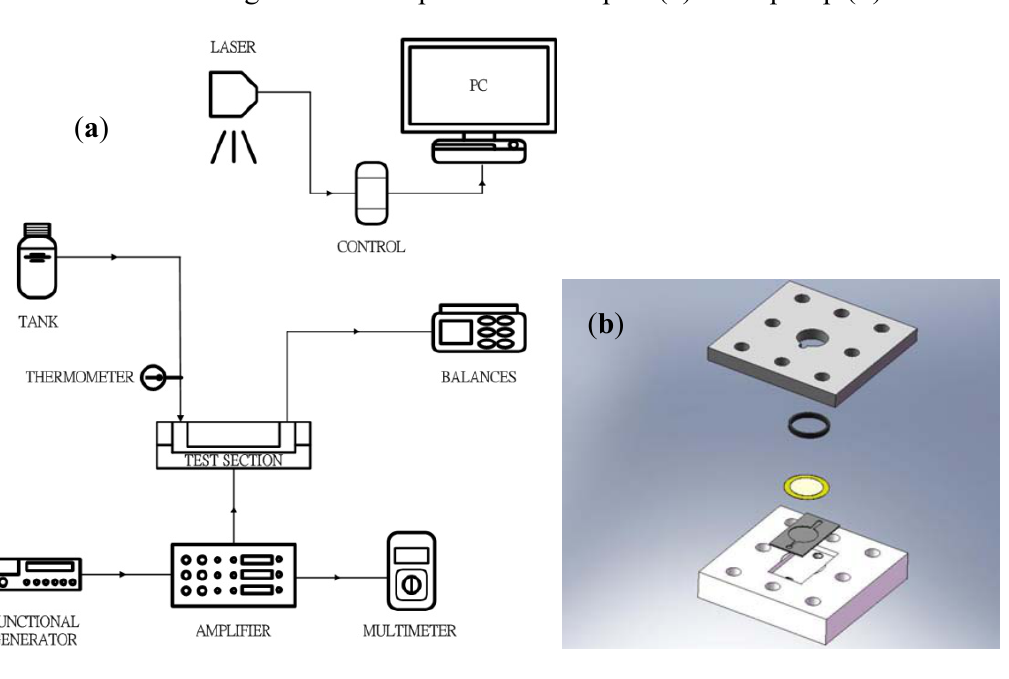
Figure 7. Schematic diagram of the experimental setup of ( a ) micropump ( b ) test